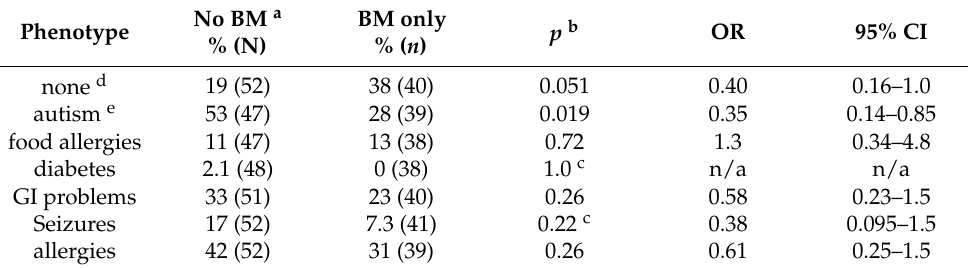
Table 6. Analysis of FXS comorbidities as a function of only breast